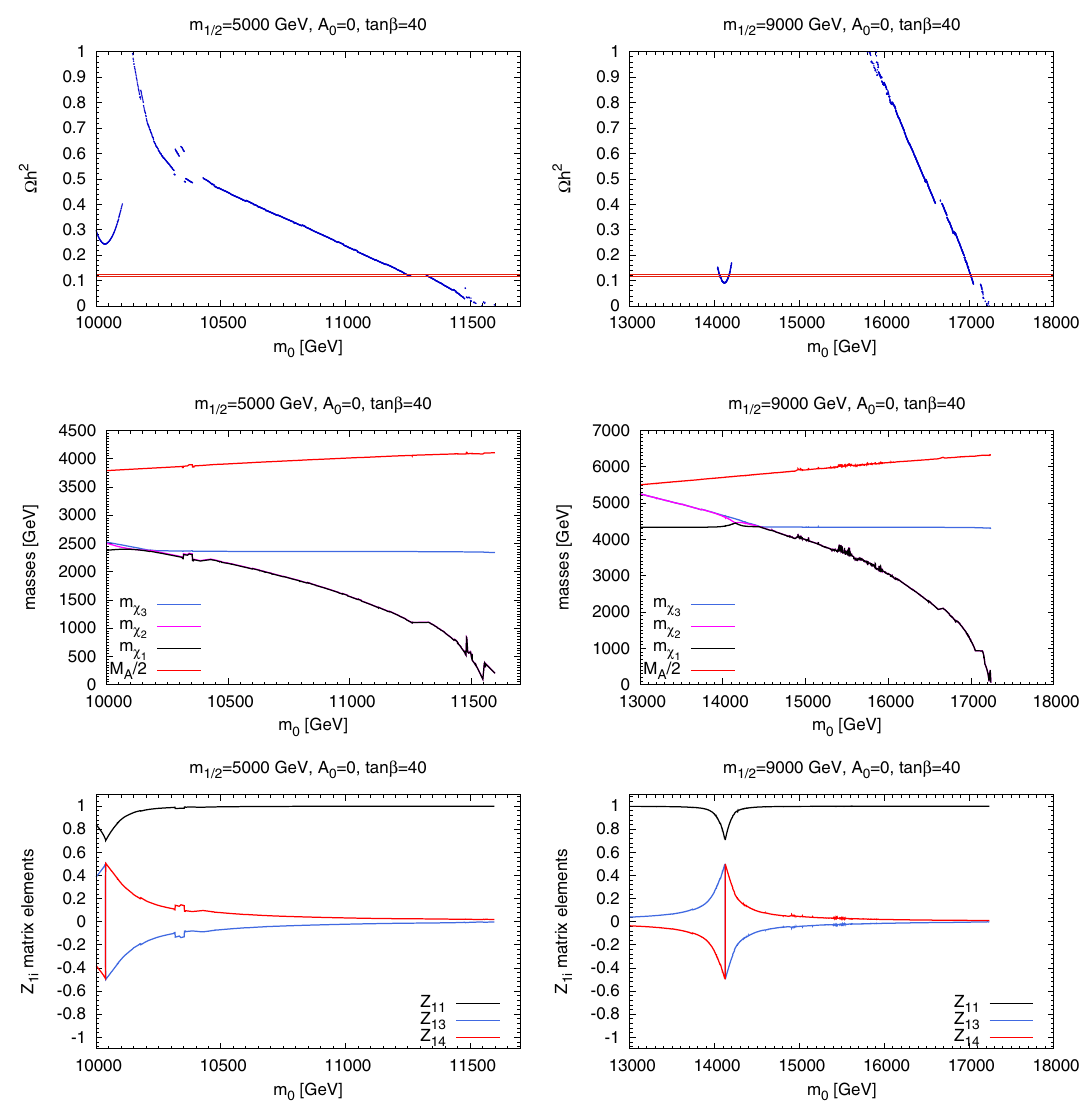
Fig. 2 Cuts across the ( m 1 / 2 , m 0 ) planes for tan β = 40, A 0 = 0 and μ > 0 for varying m 0 and fixed m 1 / 2 = 5 . 0 TeV (left panels) and 9 . 0 TeV (right panels), showing the dark matter density (top panels), particle masses (middle panels) and the composition of the bino-like neutralino (bottom panels)